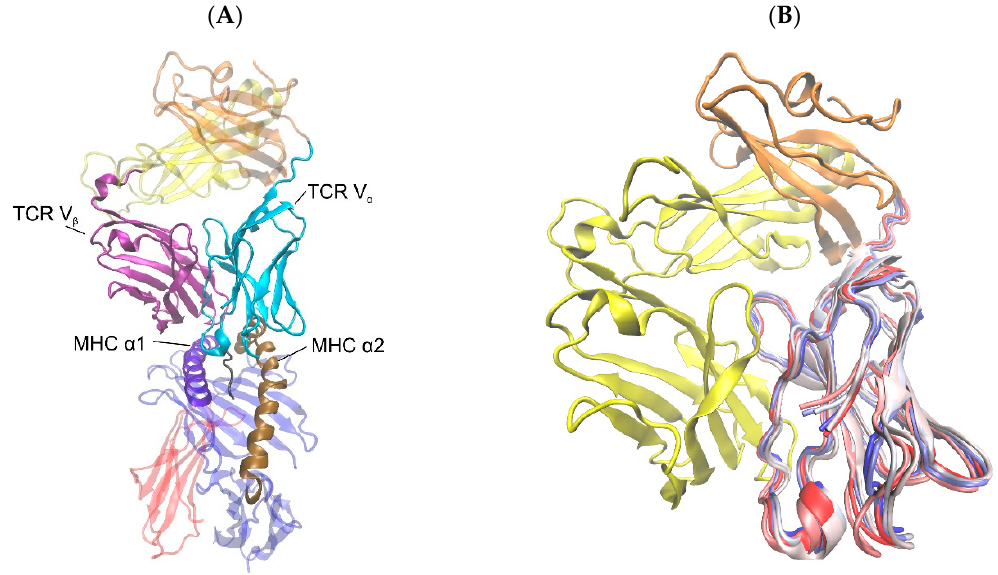
Figure 1. Cartoon representations of TCR and pMHC molecules. ( A ) TCR-pMHC complex from the crystal structure 3KPS with highlighted domains TCR V α (cyan), TCR V β (purple), MHC α 1 (violet), and MHC α 2 (ochre), TCR constant domain α (orange), TCR constant domain β (yellow), MHC α 3 (blue), MHC β -microglobulin (red), peptide (black). ( B ) TCR alone with overlaid snapshots of domain TCR V α at every 8 ns from a 40 ns simulation run of the TCR-pMHC complex to illustrate the extent of domain movements. The beginning of the trajectory appears in red, the middle in white, and the end in blue. The figures were produced using VMD [22] .